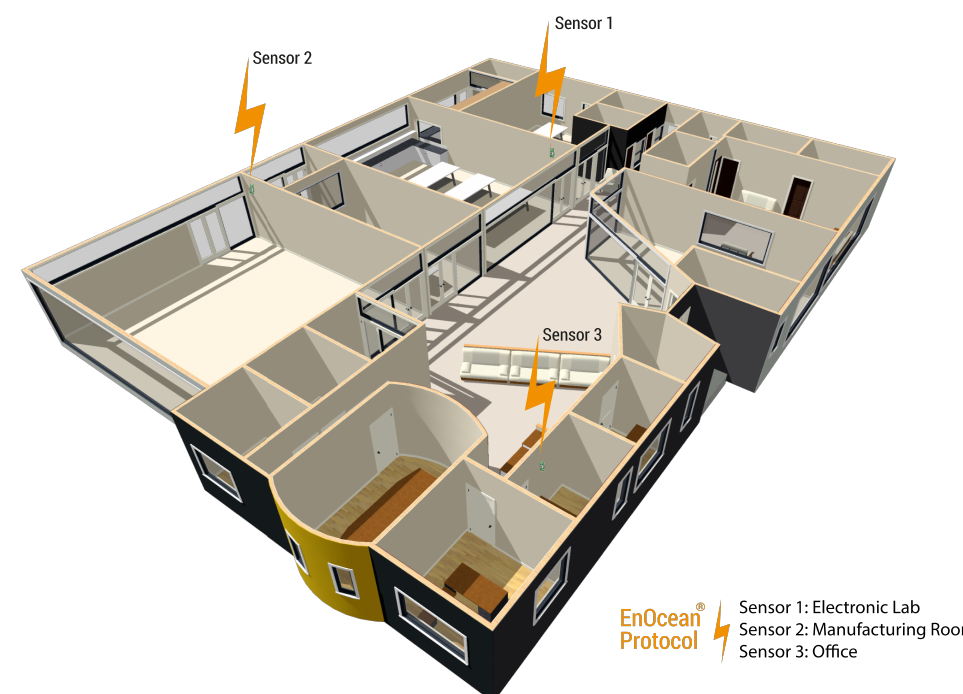
Figure 3. Layout of the building showing the location of the three temperature